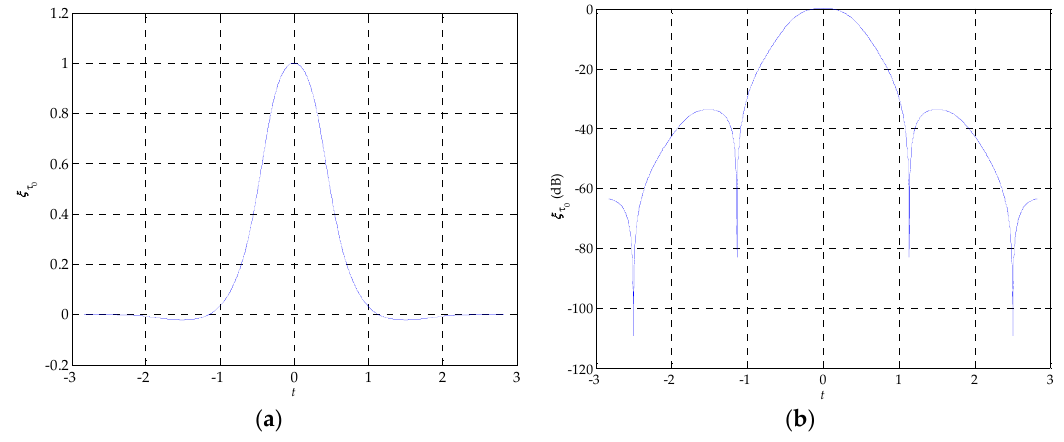
Figure 2. IOTA filter in linear and decibel formats: ( a ) Linear format, ( b ) Decibel format.